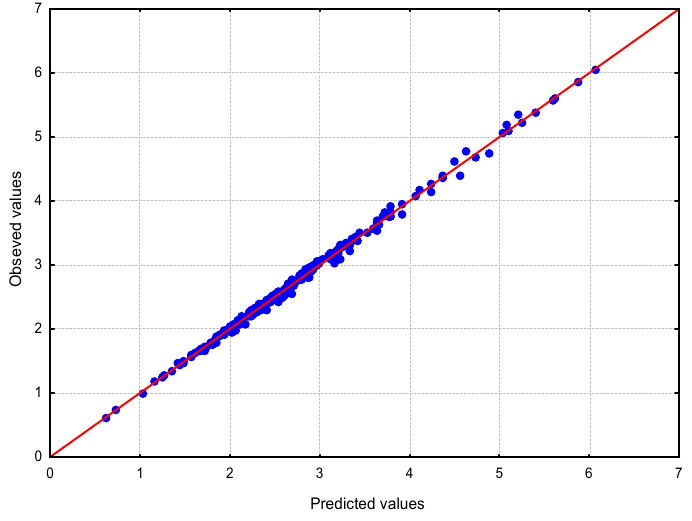
The comparison between the observed values and those calculated from the regression function is shown in Figure 6. This is confirmed by the very good agreement of the calculation results with the empirical data.